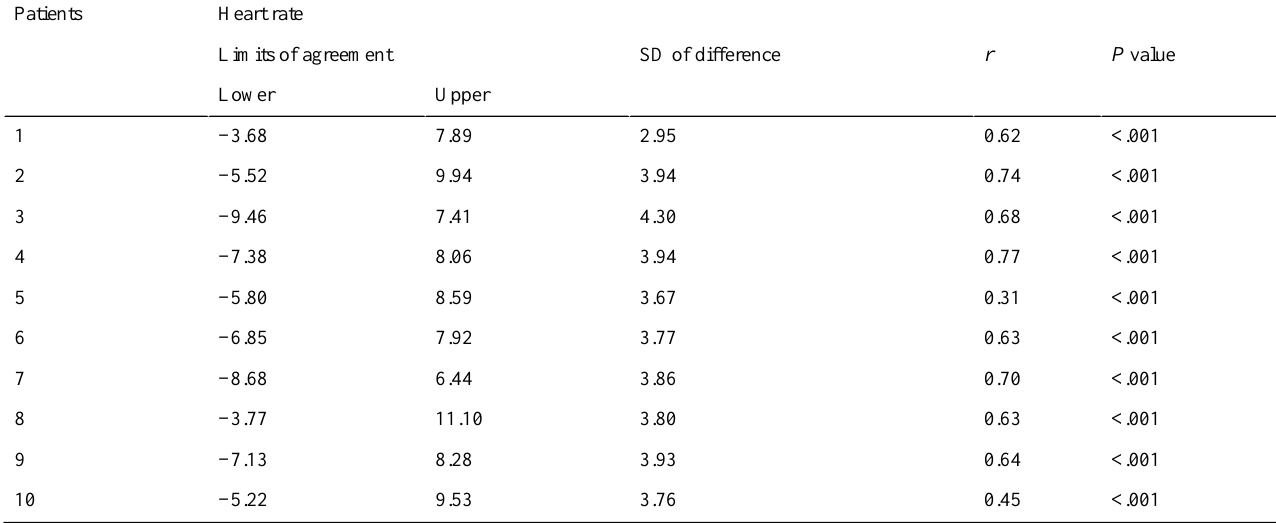
Table 4. Limits of agreement of the Bland-Altman plots, Pearson correlation coefficient, and P value for heart rate detection.